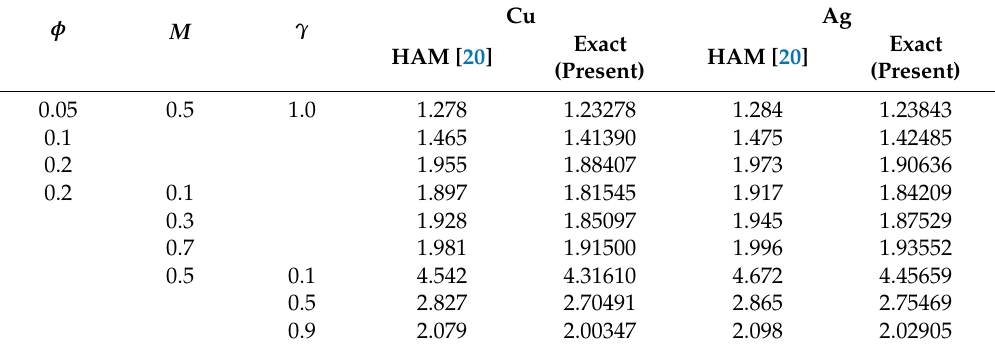
Table 2. Comparisons between the numerical results of skin friction coefficient [20] and the present exact values for copper and silver at µ = 0 and λ =